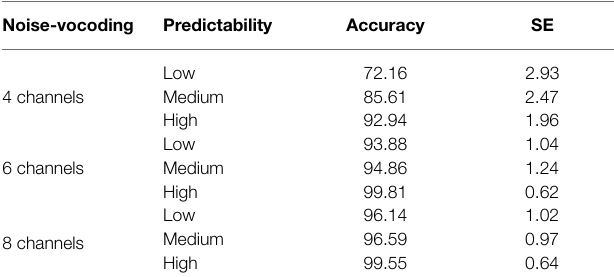
TABLE 5 | Mean response accuracy in unpredictable channel context.